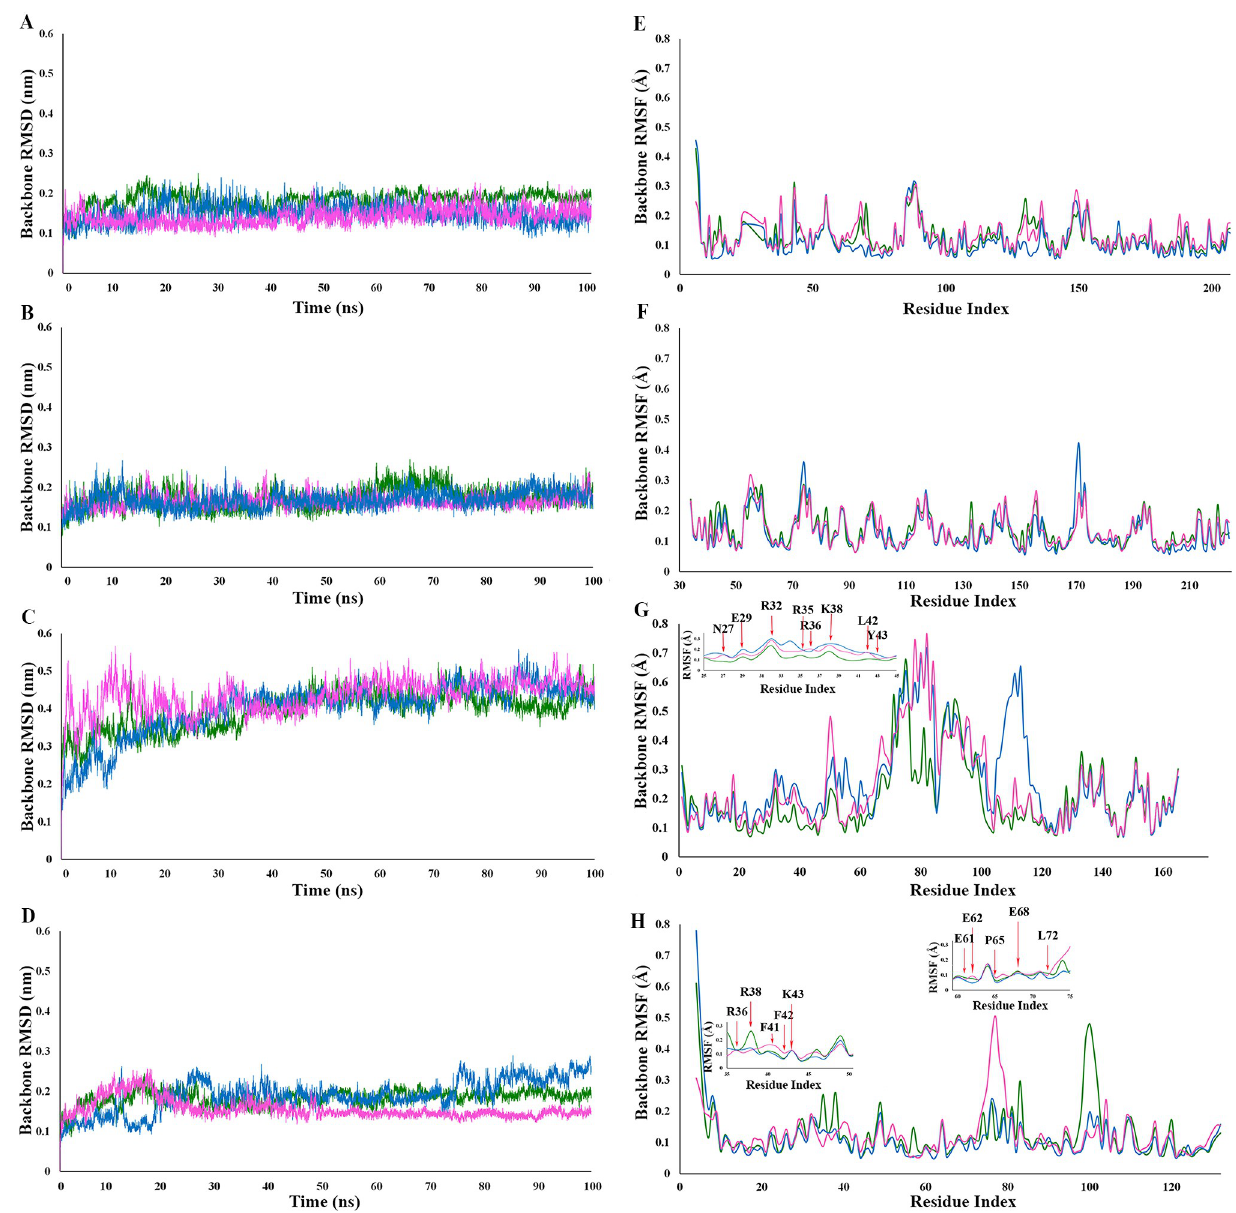
Fig 3. Back-bone root mean square fluctuations (RMSD). A. IL-2R β (the native (green), mutant 1 (blue) and mutant 2 (magenta) proteins), B. IL-2R γ c (the native (green), mutant 1 (blue) and mutant 2 (magenta) proteins), C. IL-2R α (the native (green), mutant 1 (blue) and mutant 2 (magenta) proteins), and D. Native IL-2 (green), mutant 1 (blue) and mutant 2 (magenta) proteins) during 100ns of MDs. Back-bone root mean square fluctuations (RMSF) of, E. IL-2R β residues (the native (green), mutant 1 (blue) and mutant 2 (magenta) proteins, F. γ c residues (the native (green), mutant 1 (blue) and mutant 2 (magenta) proteins), G. IL-2R α residues (the native (green), mutant 1 (blue) and mutant 2 (magenta) proteins), and H. wtIL-2 residues (green), mutant 1 (blue) and mutant 2 (magenta) during 100ns of